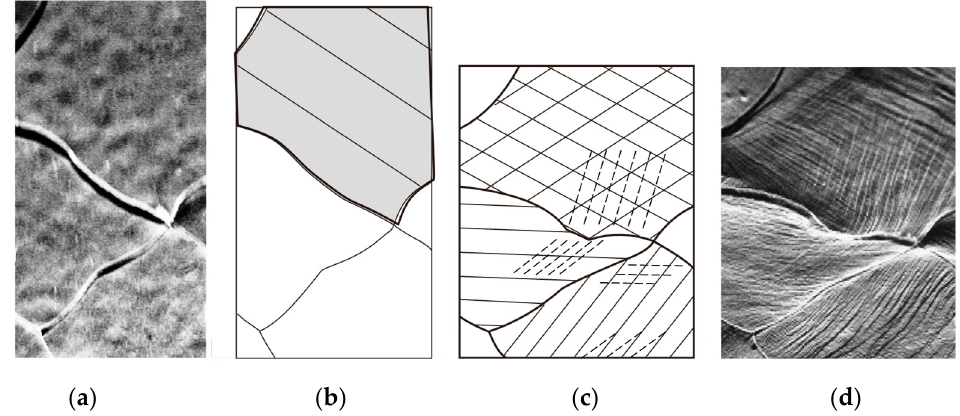
Figure 1. Grain structure evolution before and after compression of an interstitial-free steel sample, Reproduced with permission from [13], Elsevier, 2016; analysis of intergranular mechanical interaction and corresponding stress and strain equilibria. ( a ) Grains before deformation; ( b ) stress and strain incompatibility induced by the first penetrating slip (parallel real lines in gray grain); ( c ) multi-slips of penetrating (parallel real lines) and nonpenetrating local slips (parallel dashed lines) under the combination of external stress and internal reaction stresses (RSs); ( d ) experimental observation of penetrating and nonpenetrating local slips.